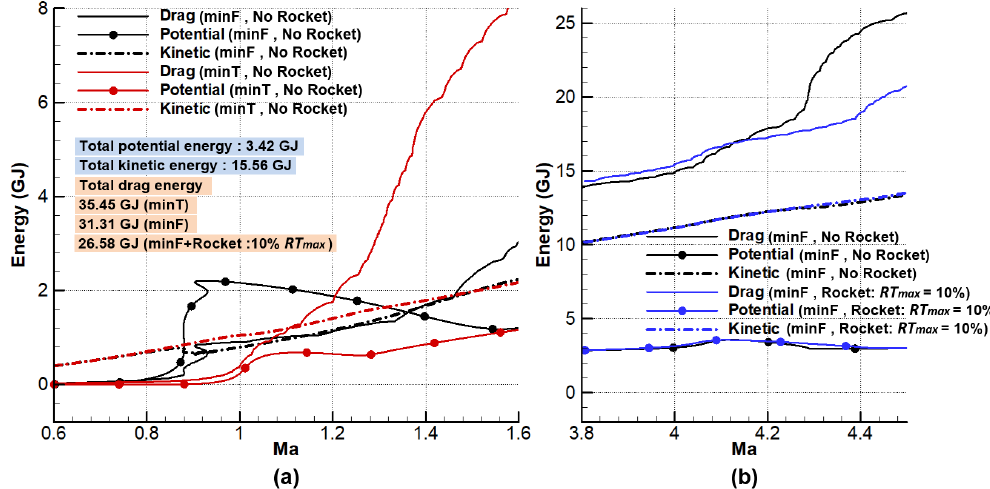
Figure 7. ( a ) Energy profiles in low Mach; ( b ) Energy profiles in high Mach.